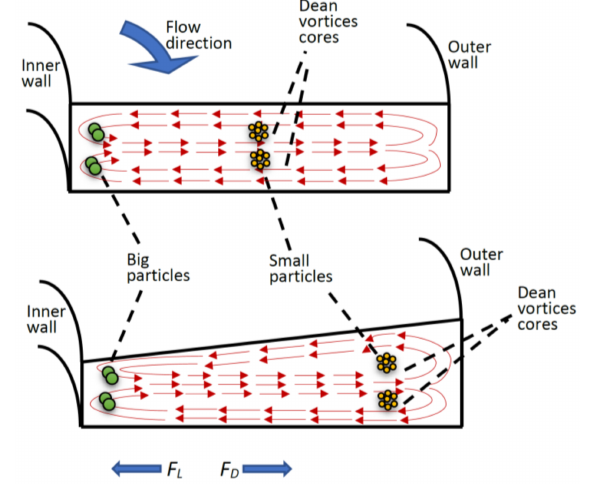
Figure 2. Schematic illustration of the spiral operational concept with demonstration of Dean vortices and equilibrium position of different size particles ( top ) rectangular spiral channel with centered core of Dean vortices, ( bottom ) trapezoidal spiral channel with Dean vortices cores shifted towards the outer wall of the spiral channel, as a result, the equilibrium position of small particles is shifted for better separation